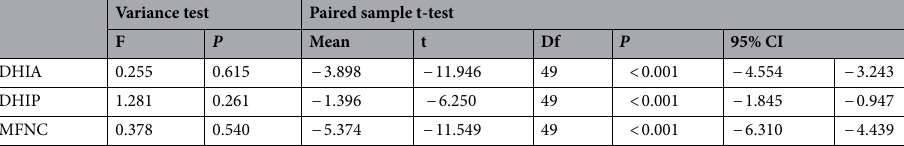
Table 5. Comparison between slipped segment (L4/5) and non-slipped segment (L3/4) in the case group. CI Confidence interval.